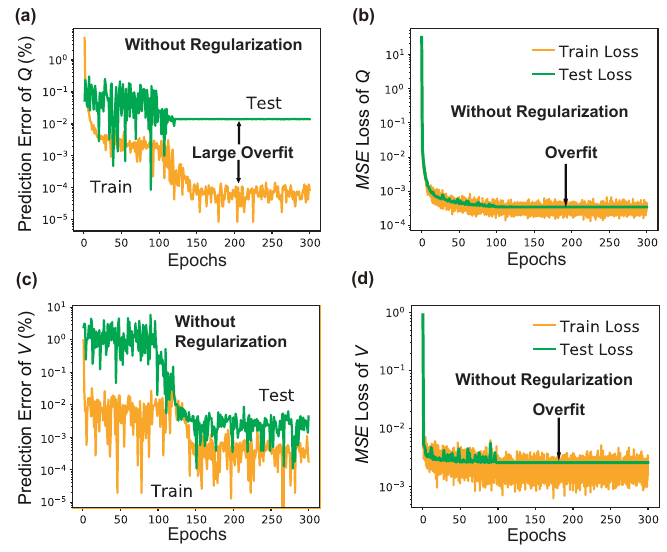
Figure 11. Results of training LRS-RCNN for L3 when no L2 regularization is used. The figure has the same order as Figure 8. It is observed that large overfittings are present in ( a – d ) in this